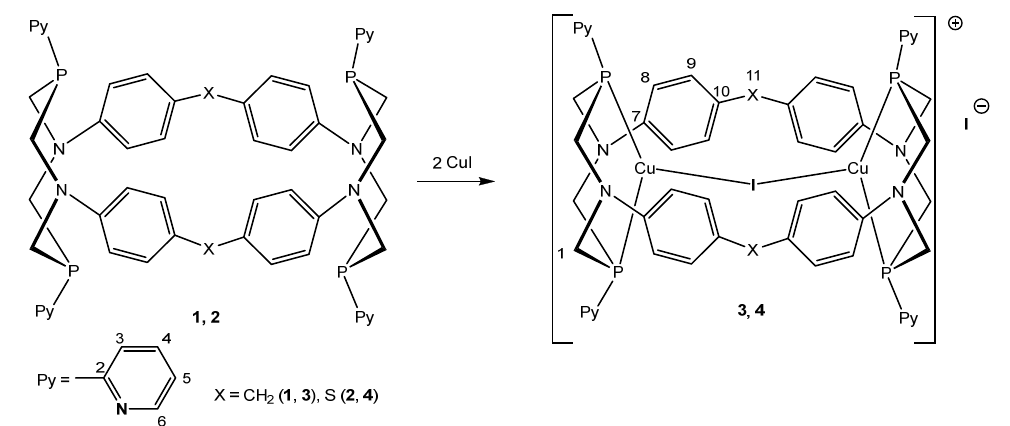
Scheme 2. Synthesis of copper(I) complexes of 28-membered cyclophanes 3 and 4